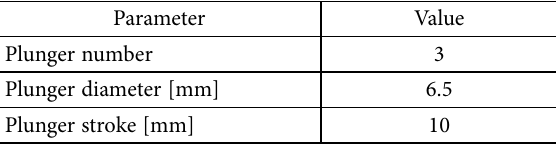
Table 2. Main characteristics of the injection pump Parameter